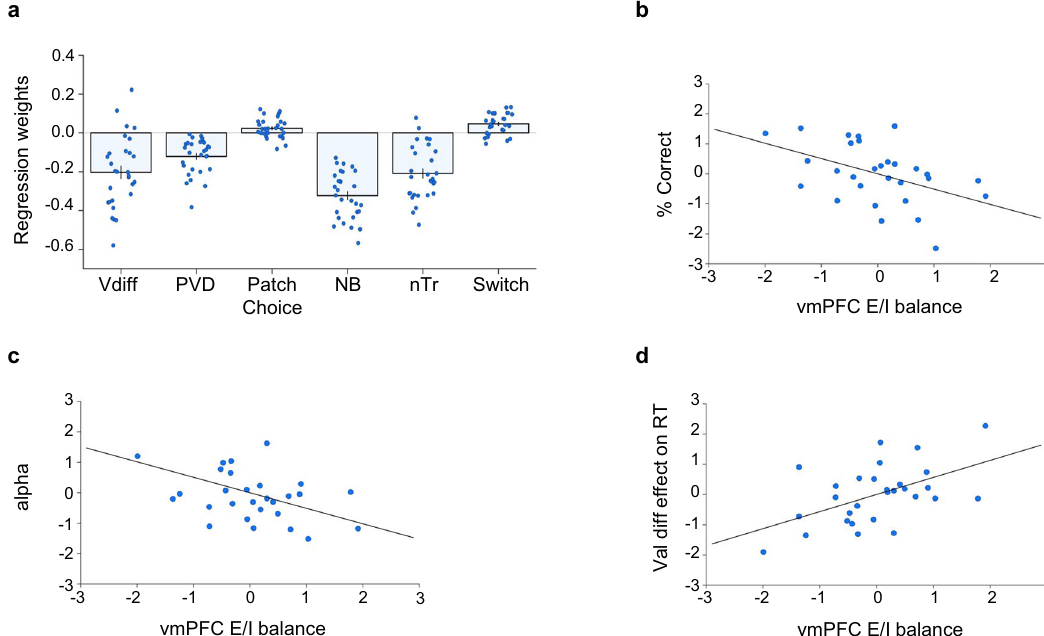
Fig. 3 Value-guided choice behaviour and cortical E/I balance. a Regression showing that participant ’ s reaction times are guided by value differences between choice options (Vdiff; two-sided one-sample t test against zero: t 28 = − 5.928, p < 0.001, CI 95 = [ − 0.273 to − 0.133], U3 1 = 0.862), patch value differences (PVD; two-sided one-sample t test against zero: ( t 28 = − 7.105, p < 0.001, CI 95 = [ − 0.156 to − 0.086], U3 1 = 1), choices in the patch phase (two-sided one-sample t test against zero: t 28 = 2.538, p = 0.017, CI 95 = [0.005 to 0.043], U3 1 = 0.345), whether each trial is a no-brainer trial (NB; two- sided one-sample t test against zero: t 28 = − 14.344, p < 0.001, CI 95 = [ − 0.369 to − 0.277], U3 1 = 1), trial number (nTr; two-sided one-sample t test against zero: t 28 = − 8.119, p < 0.001, CI 95 = [ − 0.261 to − 0.156], U3 1 = 0.931) and whether each trial was a patch-leaving trial (Switch; two-sided one- sample t test against zero: t 28 = 4.590, p < 0.001, CI 95 = [0.026 to 0.067], U3 1 = 0.276). Individual data points are overlaid as dot plots. Bars represent mean values across participants. Error bars indicate standard error of the mean. b Accuracy of value-guided choice is highest in participants with low levels of E/I balance in vmPFC (Pearson correlation on residuals: r = − 0.461, p = 0.012, CI 95 = [ − 0.708 to − 0.114]). c Distortions in reward magnitude weighting relate to E/I balance in vmPFC (Pearson correlation on residuals: r = − 0.457, p = 0.013, CI 95 = [ − 0.705 to − 0.109]). d Participants with high levels of E/I balance in vmPFC exhibit less slowing in dif fi cult trials (Val diff = value difference) during value-guided choice (Pearson correlation